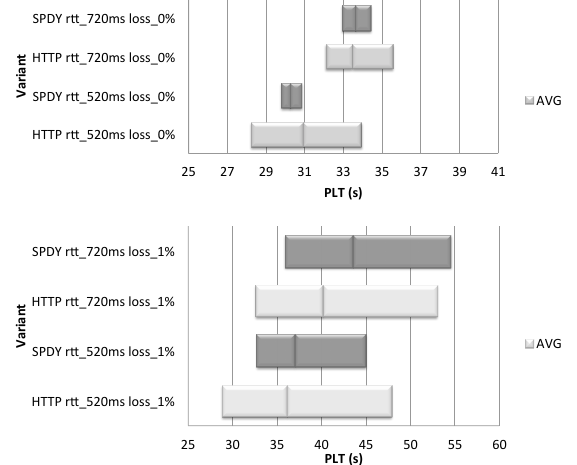
Figure 3. Average, maximum and minimum PLT values for all the sites used in the different trials. Values are in seconds. Figure 4 o ff ers a breakdown of performances in terms of PLT with a per-site granularity, which have been numbered according to the ranking of Table 1.